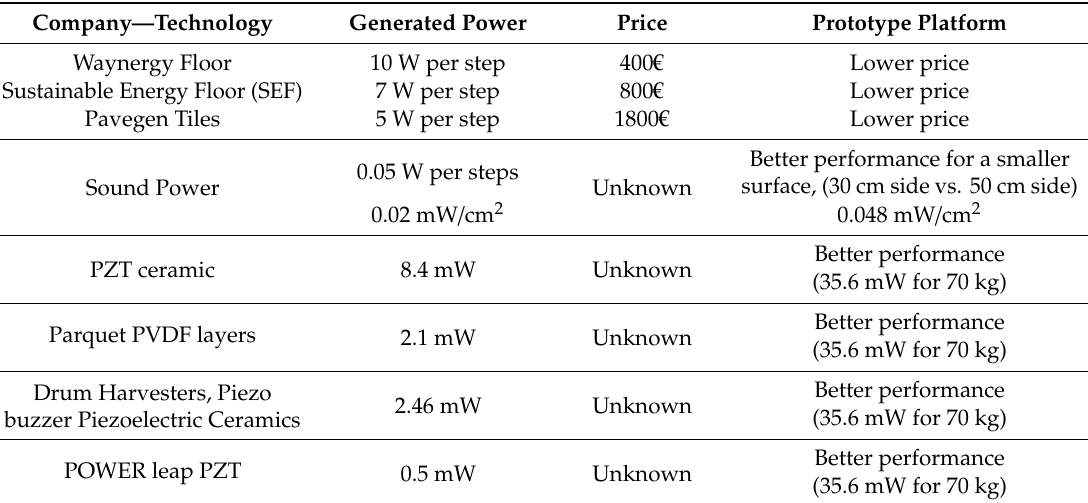
Table 6. Comparison of piezoelectric platform with commercial